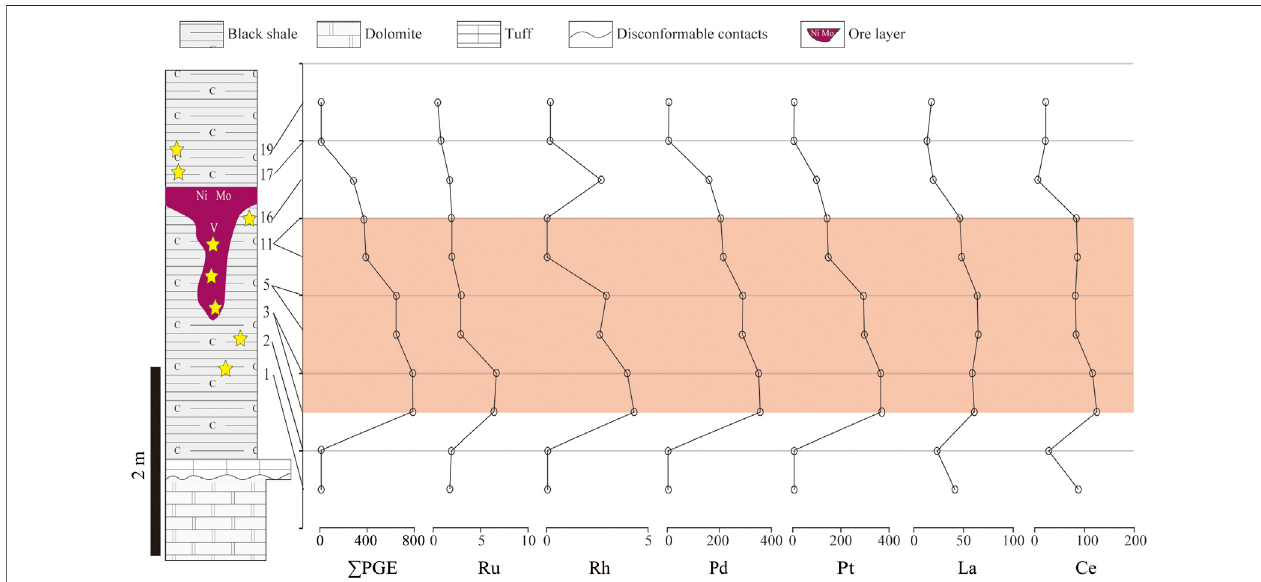
FIGURE 3 | Plot of Σ PGE, Ru, Rh, Pd, Pt La, Ce variations in the Shuidong pro fi le.